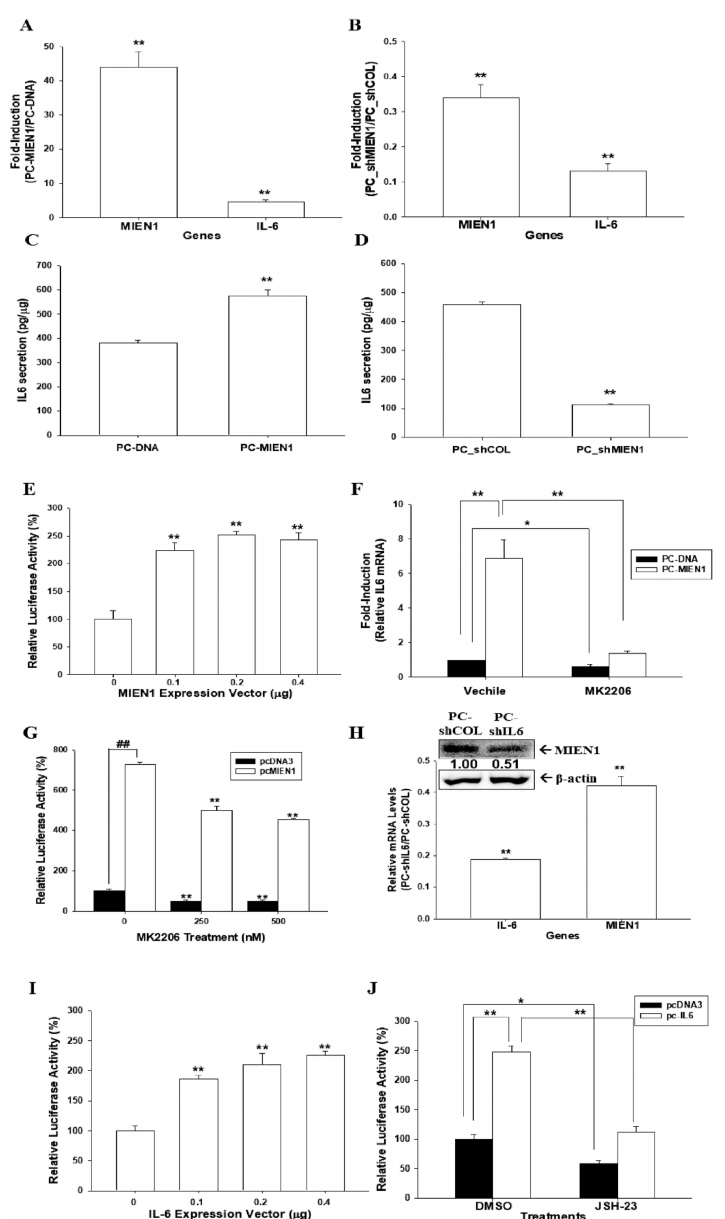
Figure 6. Modulation between migration and invasion enhancer 1 (MIEN1) and interleukin-6 (IL-6) in prostatecarcinomaPC-3cells.RelativeexpressionofMIEN1andIL-6afterectopicMIEN1overexpression ( A ) or MIEN1 knockdown ( B ) in PC3 cells as determined by RT-qPCR assays. Data are presented as the mean fold induction of the mRNA levels ( ± standard error (SE), n = 3) relative to the mock-transfected groups PC-DNA and PC_shCOL, respectively. Secretion of IL-6 in MIEN1-overexpressing ( C ) or MIEN1-knockdown ( D ) PC3 cells. ( E ) Relative luciferase activity of IL-6 reporter vector after cotransfection with various dosages of MIEN1 expression vector ( ± SE, n = 6). ( F ) Relative expression of IL-6 in MIEN1-overexpressing PC3 cells treated with / without MK2206 as determined by RT-qPCR assays ( ± SE, n = 3). ( G ) The relative luciferase activity of IL-6 reporter vectors after transient overexpression of MIEN1 expression vector and treatment with / without MK2206 ( ± SE, n = 6). ( H ) Relative expression of IL-6 and MIEN1 after MIEN1 knockdown in PC3 cells determined by immunoblot and RT-qPCR assays. The number indicates the ratio of MIEN1 / β -Actin in relation to PC-shCOL cells. ( I ) Relative luciferase activity of MIEN1 reporter vector after cotransfection with various dosages of IL-6 expression vector. ( J ) The relative luciferase activity of MIEN1 reporter vectors after transient overexpression of IL-6 expression vector and treatment with / without JSH-23 ( ± SE, n = 6). * p < 0.05, ** ,## p <